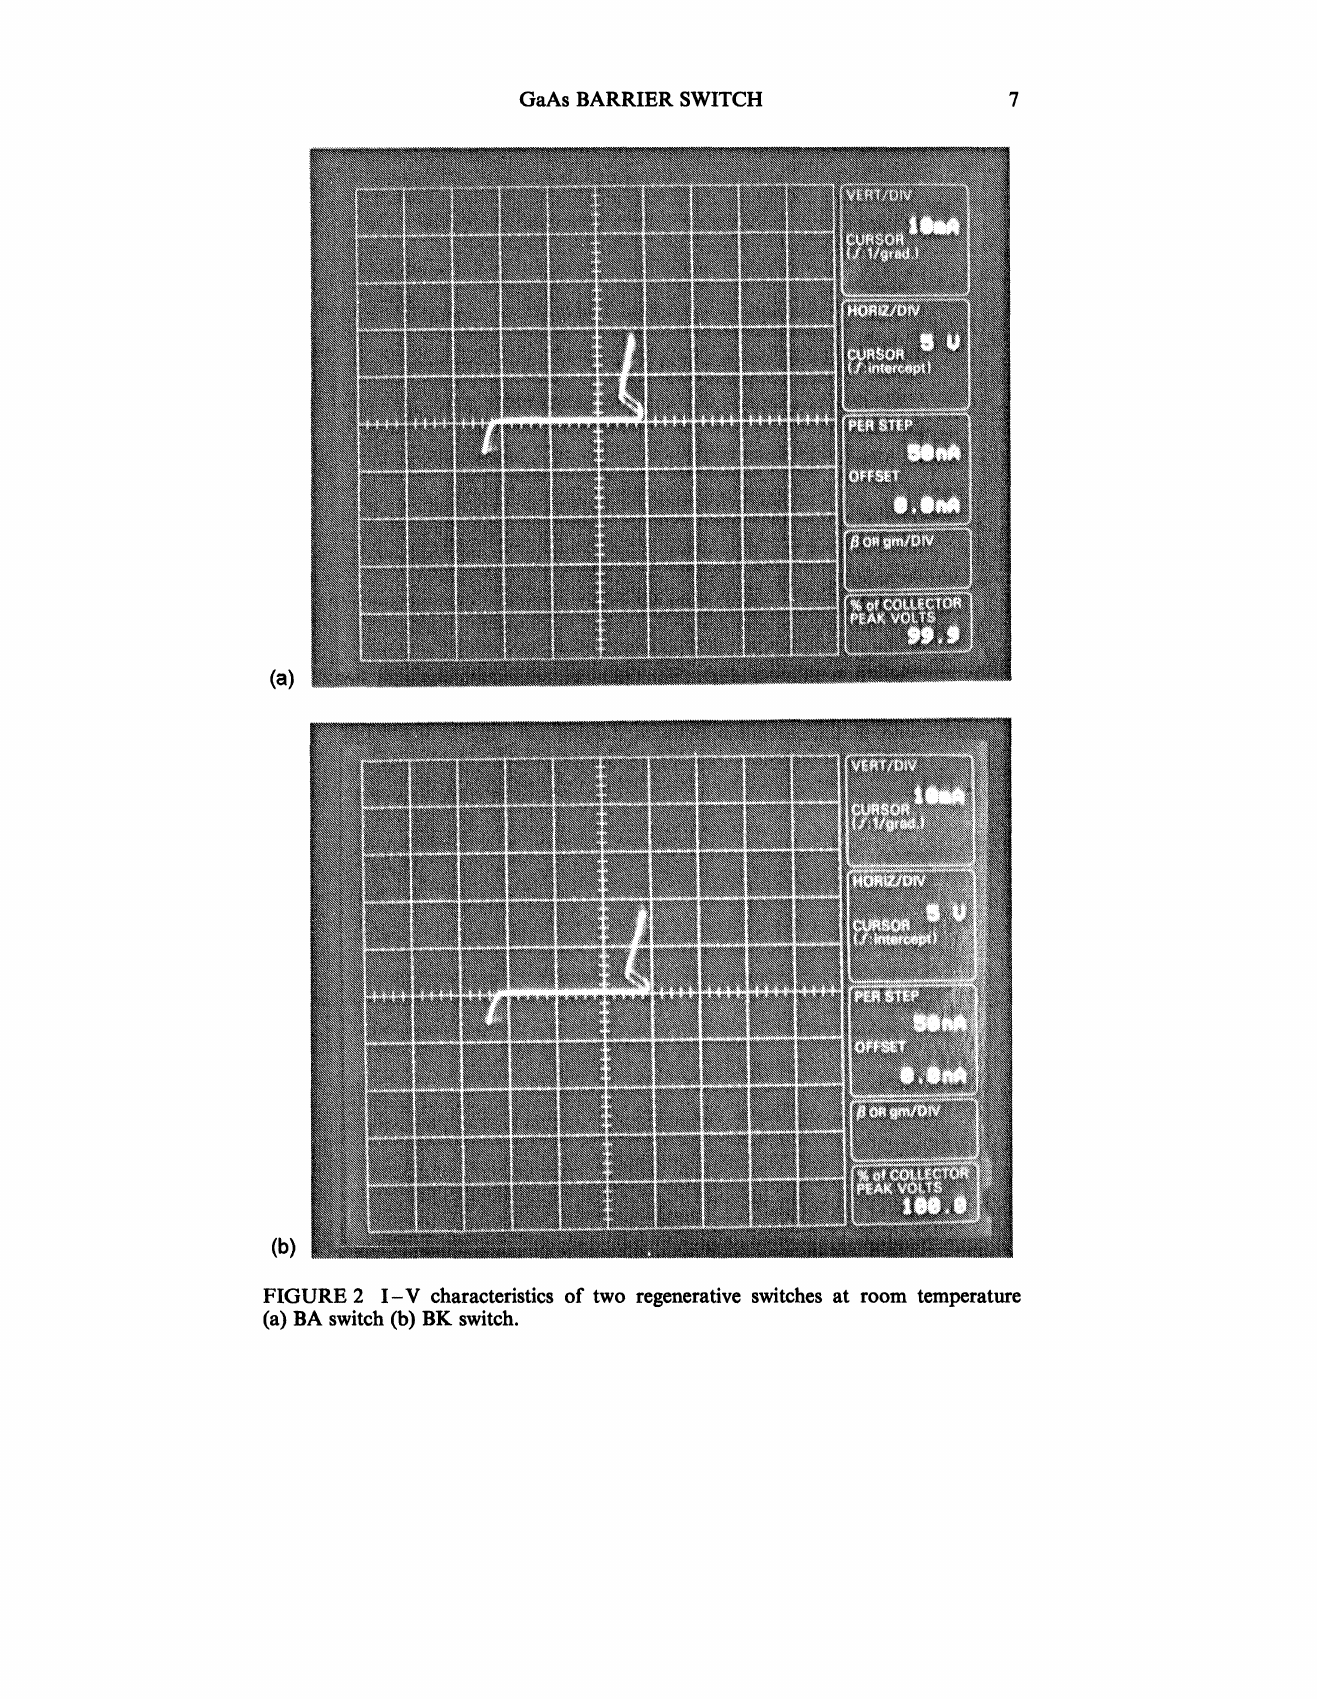
FIGURE 2 I-V characteristics of two regenerative switches at room temperature (a) BA switch (b) BK